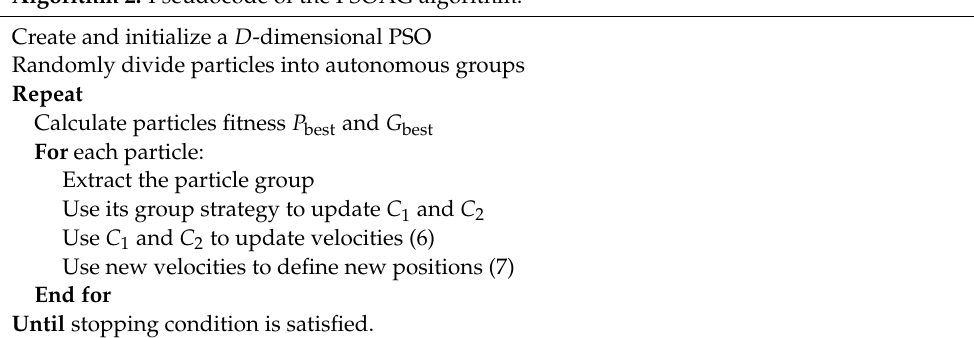
Algorithm 2. Pseudocode of the PSOAG